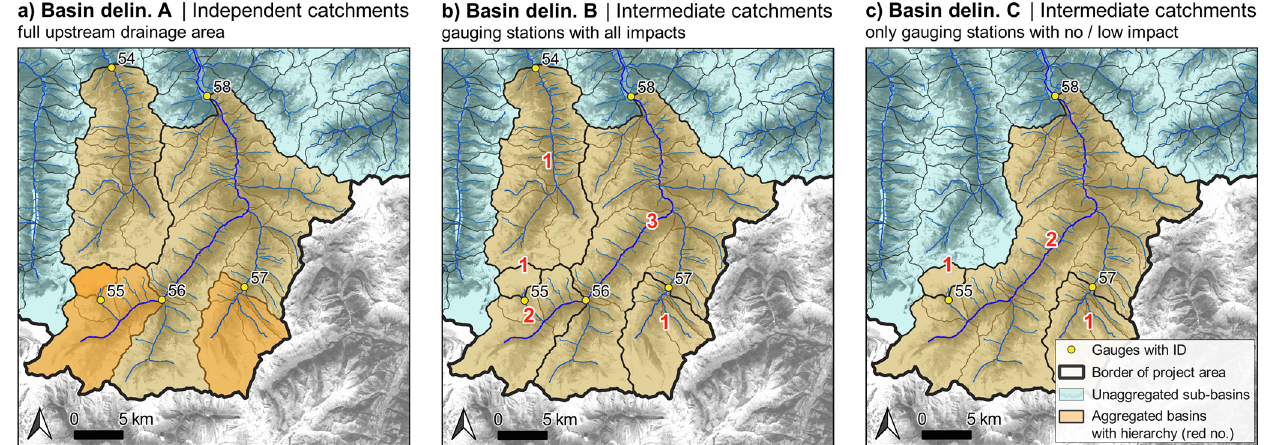
Figure 2. Types of basin delineation in LamaH shown with an example. (a) Basin delineation A (similar to the well-known CAMELS datasets): the aggregation area corresponds to the topographic catchment area of a gauge. In plot (a) , the aggregation area of gauges 56 and 57 overlaps with that of gauge 58, and the aggregation area of gauge 55 overlaps with that of gauges 56 and 58 (indicated by the different color tones). (b) Basin delineation B: the aggregation areas in this method consider the difference in area (intermediate catchments) between the topographic catchment area of the respective gauge and the catchment area of the next upstream gauges. Consequently, there are no overlaps, but a gauge hierarchy is necessary. The hierarchy of the gauges 54, 55 and 57 is 1 because there is no upstream gauge. Gauge 56 has hierarchy 2 because gauge 55 with hierarchy 1 is upstream. Hierarchy 3 is assigned to gauge 58 because there is at least one gauge with hierarchy 2 (gauge 56) in the upstream area. (c) Basin delineation C: similar to basin delineation B, but only uninfluenced or low-influenced gauges/catchments (Sect. 5.8) are considered. In plot (c) , it is assumed that gauges 54 and 56 are strongly influenced. Consequently, these two gauges are excluded from the basin delineation. The aggregation area of gauge 58 (now hierarchy 2) includes the intermediate catchment area of gauge 56. Source of background satellite image: Google Imagery © 2020 TerraMetrics, map data © 2020. Source of stream network: TYROL